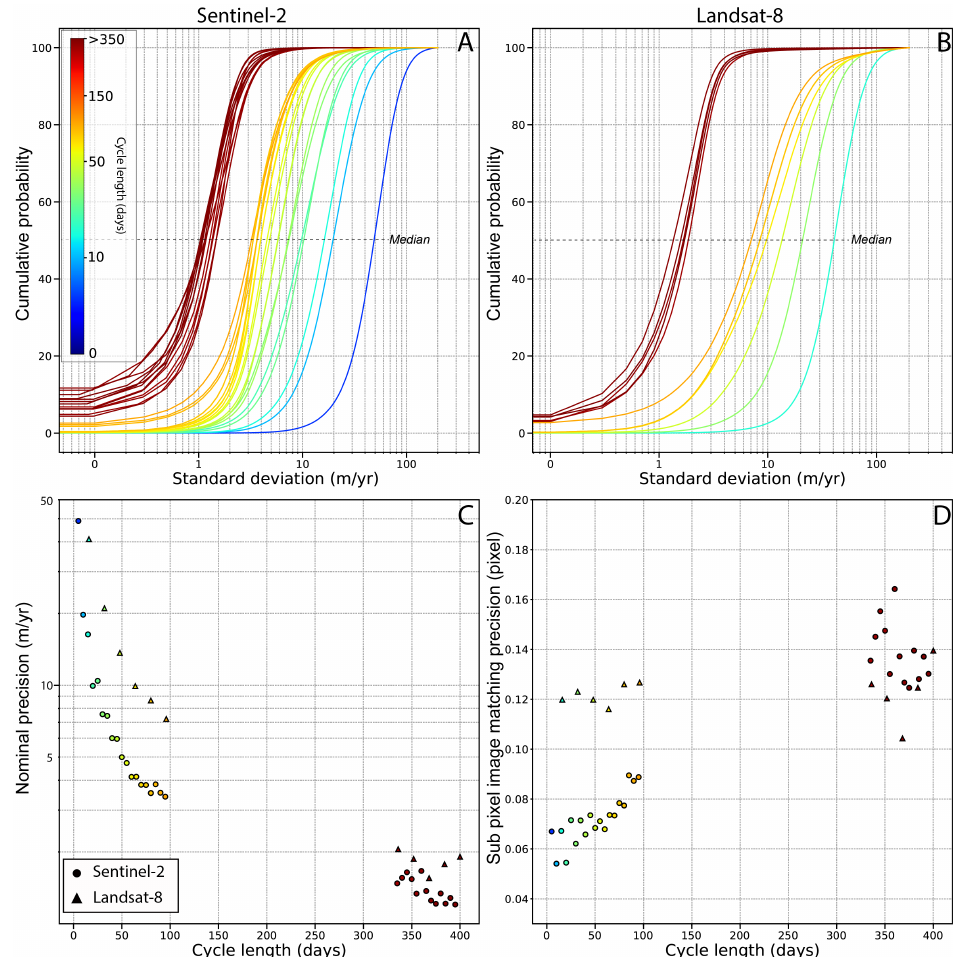
Figure 4. Analysis of Sentinel-2 and Landsat 8 precision in ice-free areas as a function of individual repeat cycles for years 2017 and 2018. ( A ) Cumulative distribution of the weighted standard deviation values in ice-free areas as a function of the length of the repeat cycle for Sentinel-2 data. Weighted standard deviation is calculated for each pixel of the grid; ( B ) Same as A for Landsat data; ( C ) Evolution of the precision as a function of the length of the repeat cycle for Sentinel-2 (circle) and Landsat 8 (triangle). Precision is taken as the median of the distribution in ( A , B ). ( D ) Evolution of the sub-pixel matching precision with the cycle length for Sentinel-2 (circle) and Landsat 8 (triangle) based on ( C ). Repeat cycle is color-coded from red for long to blue for short repeats for all